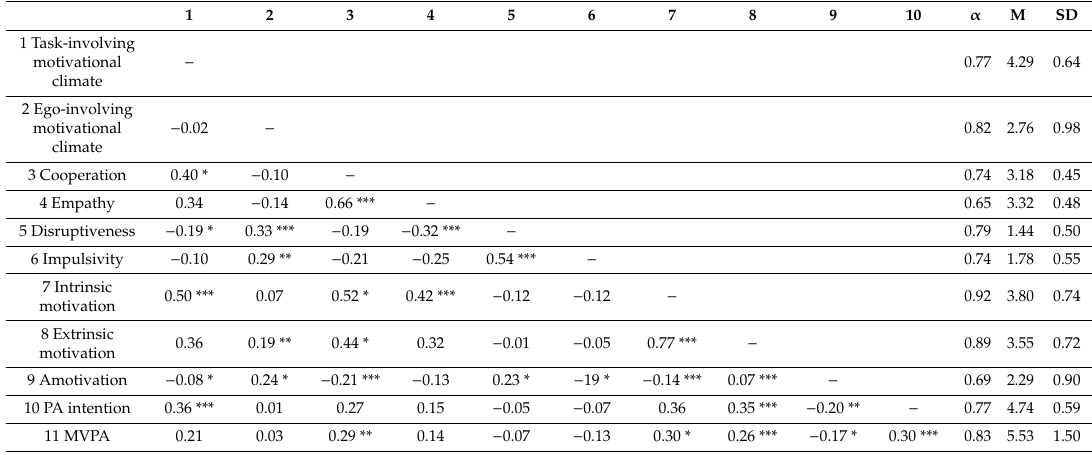
Table 1. Correlations, Cronbach alphas ( α ), means (M) and standard deviations (SD) of the study